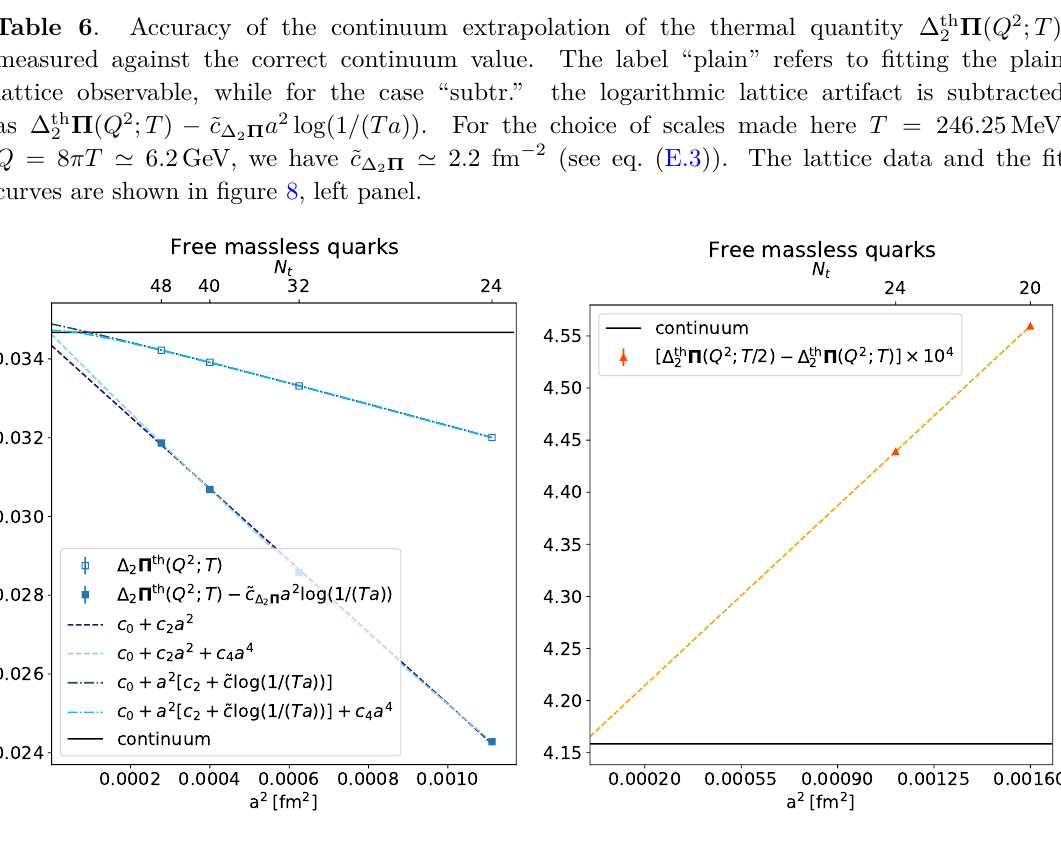
Figure 8 . Left: continuum extrapolation of the thermal observable ∆ th Π ( Q 2 ; T ) , with T = 2 246 . 25 MeV and Q = 8 πT ’ 6 . 2 GeV. The O ( a 2 log(1 /a )) lattice artifact is either included in the fit ansatz or explicitly subtracted by using the known prefactor ˜ c ∆ (E.3). The accuracy of the 2 Π resulting continuum estimates is reported in table 6. Right: continuum extrapolation of the bias correction [∆ th Π ( Q 2 ; T/ 2) − ∆ th Π ( Q 2 ; T )] , together with its known continuum value. The fit ansatz 2 2 is linear in a 2 .